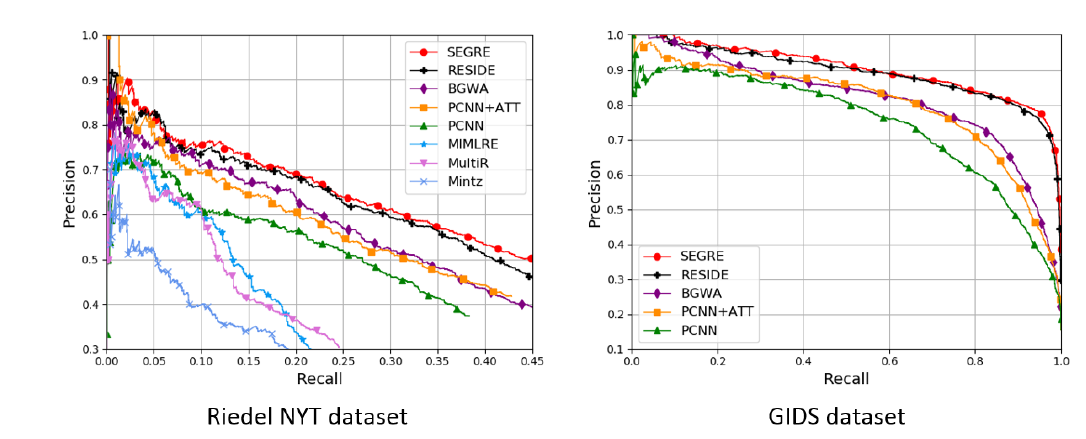
Figure 3. Comparison of Precision–Recall curves. SEGRE achieves higher precision over the entire range of recall than all the baselines on both